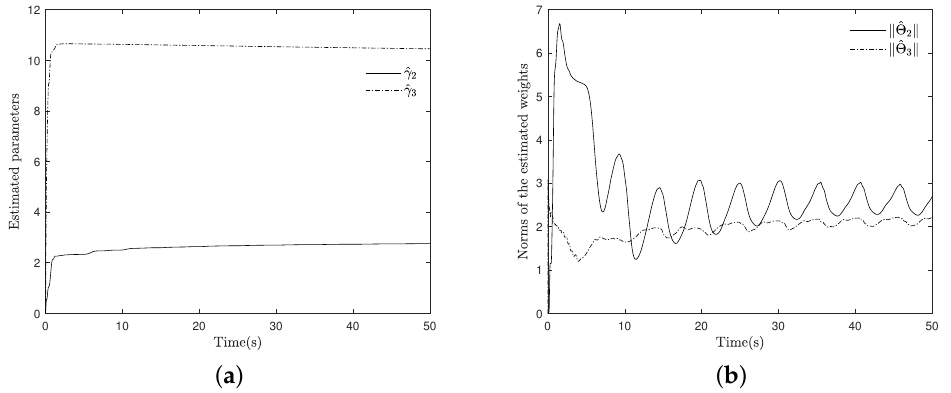
Figure 2. Estimation results of the proposed control system for Example 1 ( a ) ˆ γ j , j = 2,3; and ( b ) (cid:107) ˆ Θ j (cid:107) , j =